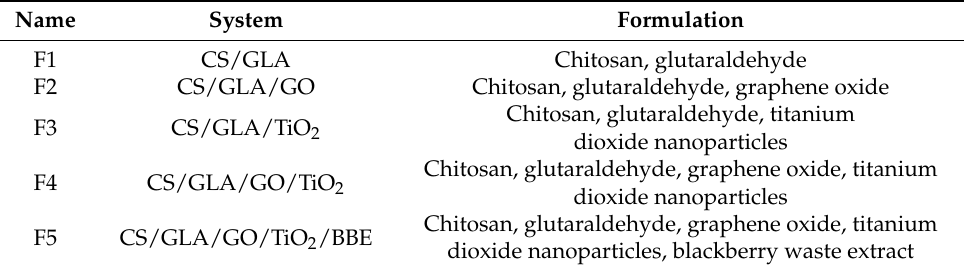
Table 1. Composition of chitosan beads for the critical bone defect